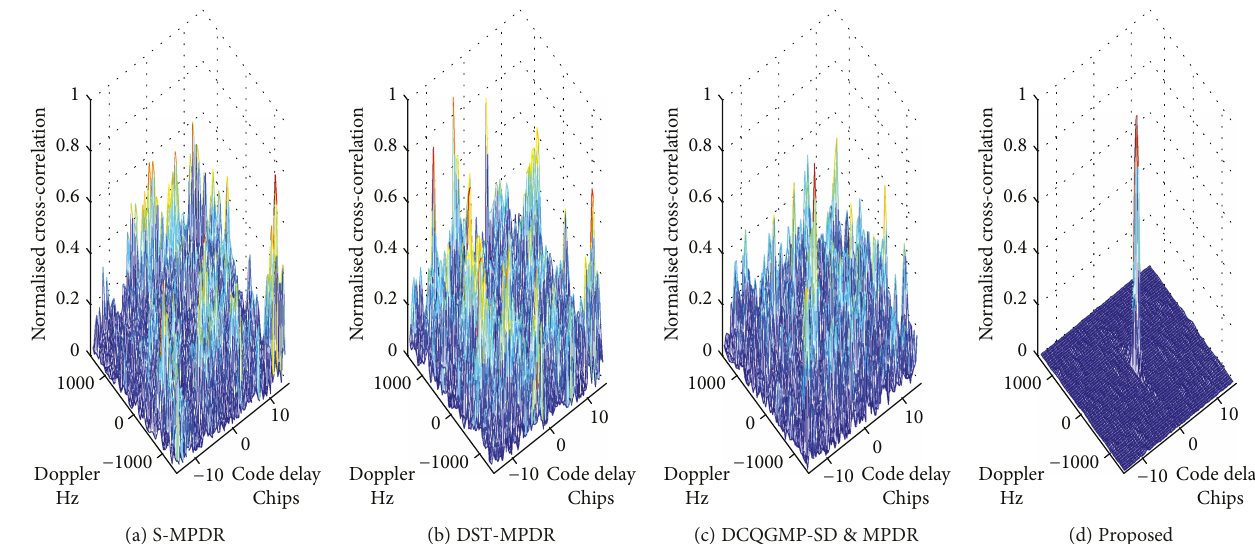
Figure 7: Correlation peaks after interference suppression for scenario IV